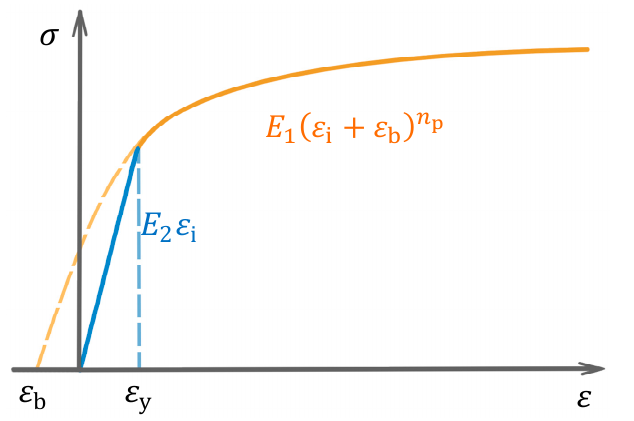
Figure 3. Linear-elastic exponential-plastic model. Table 2. Hyperparameters and structure of